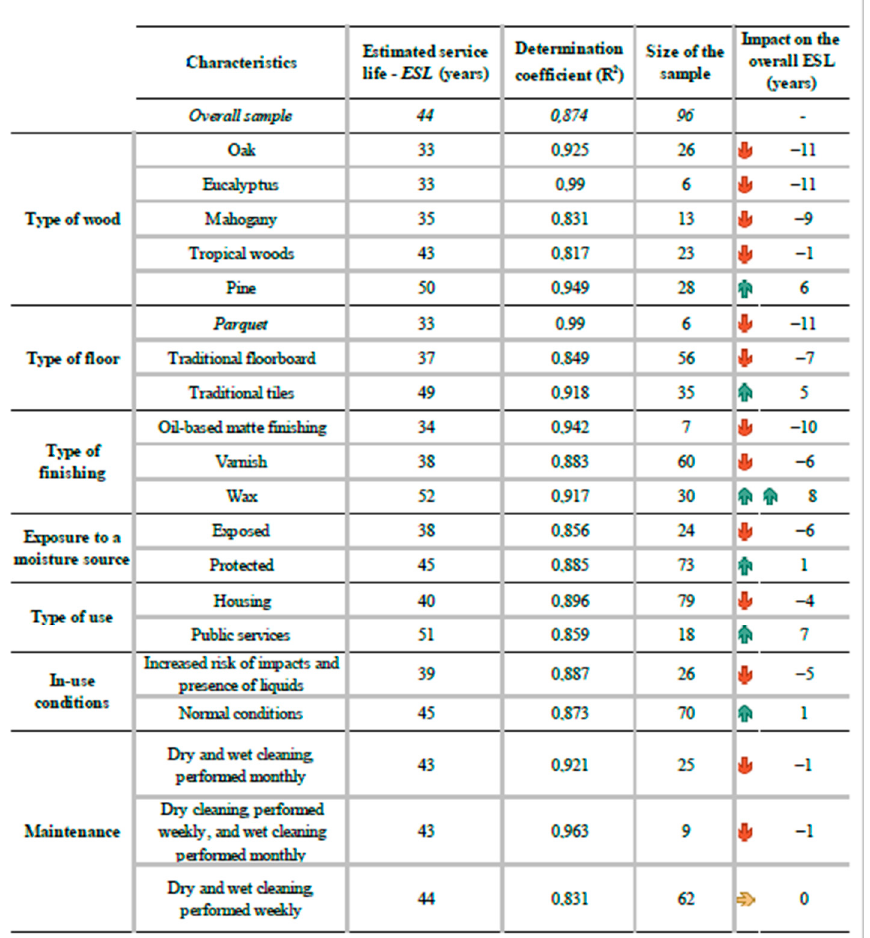
Table 7. Summary of the estimated service life obtained according to the different wood floorings’ characteristics.